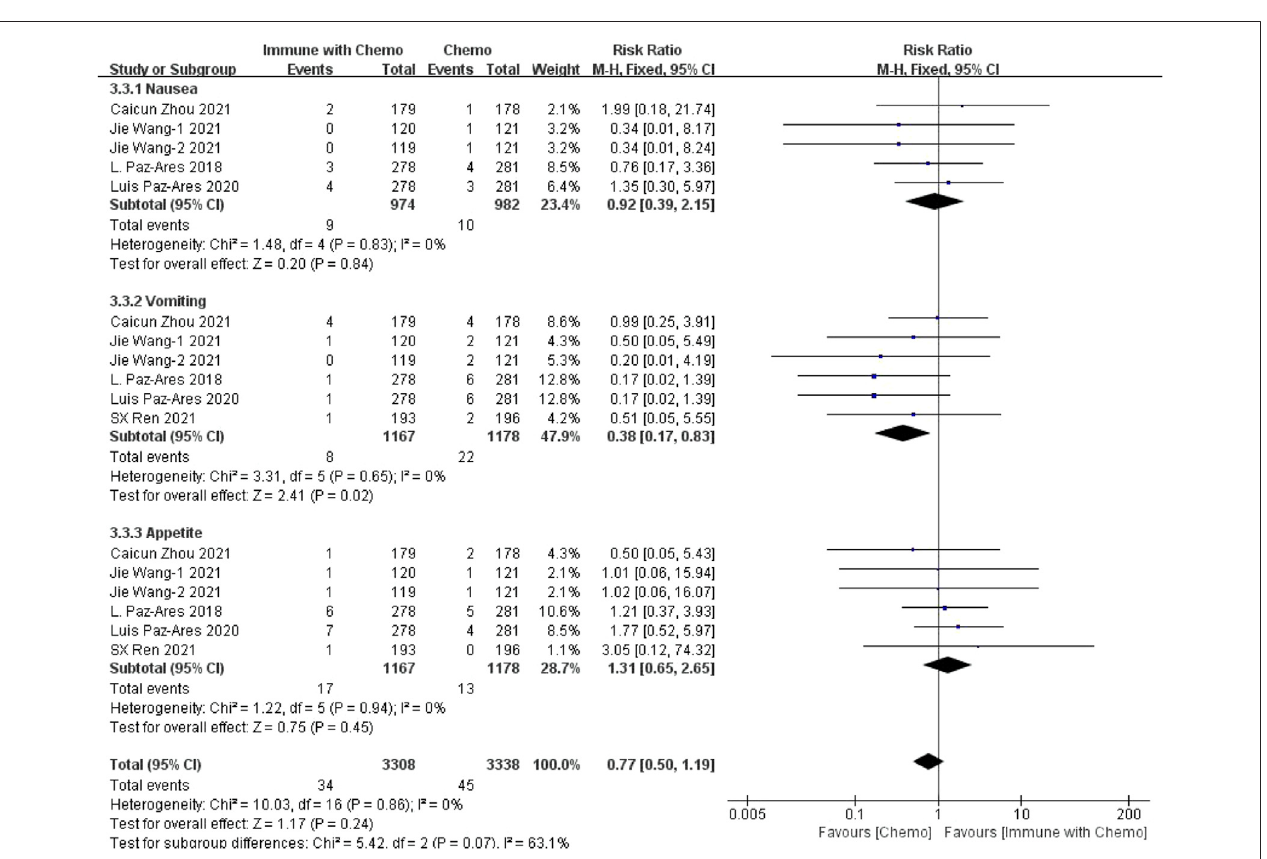
FIGURE 7 | Meta-analysis results of adverse reactions above grade 3 in gastrointestinal toxicity between the Chemo with immune group and chemo group.